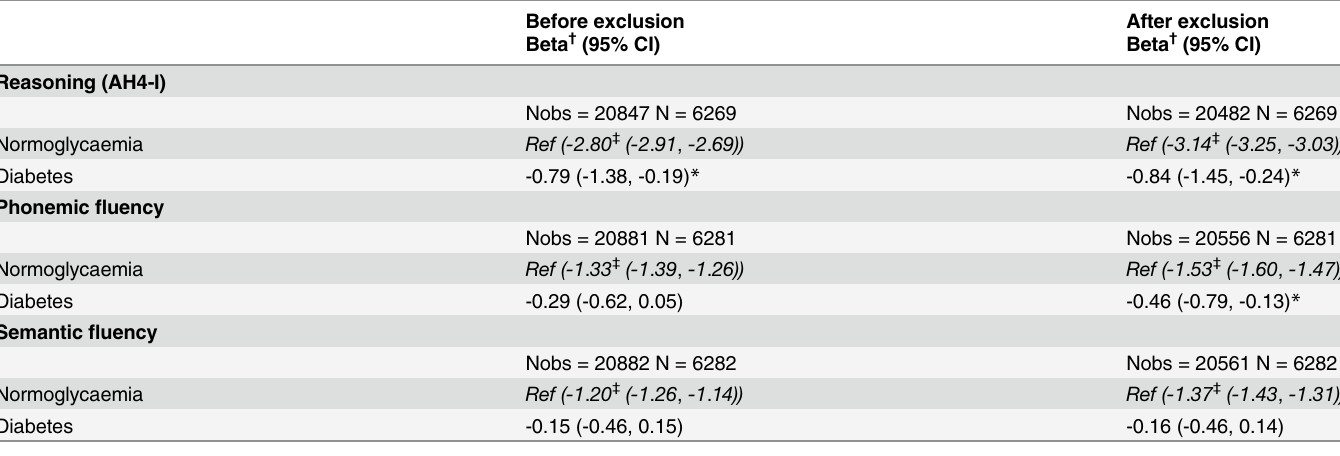
Table 5. Estimated difference in cognitive decline over 10 years, as a function of diabetes status in